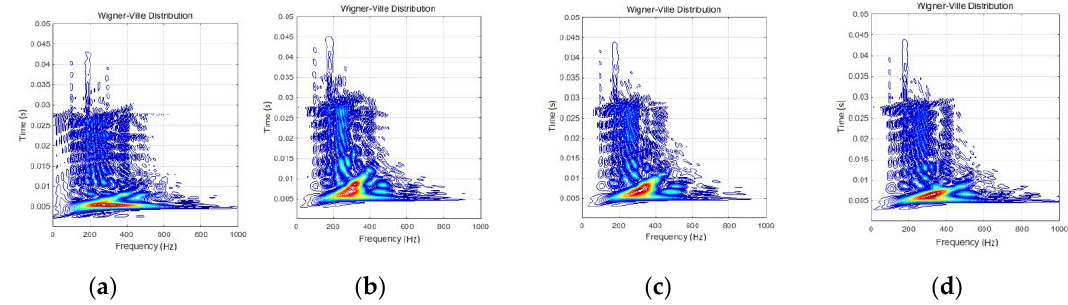
Figure 10. WVD of the rope - mass ensemble response in terms of loading mass effective acceleration: ( a ) Case 1; ( b ) Case 2; ( c ) Case 3; and ( d ) Case 4.